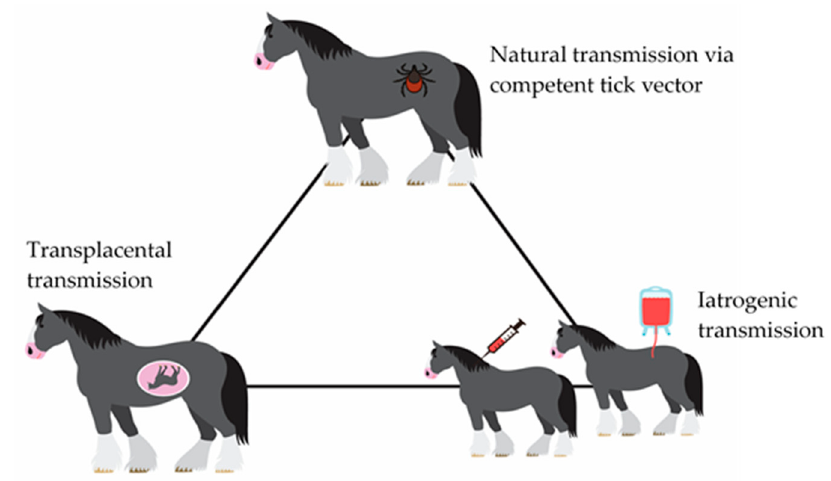
Figure 4. Possible transmission routes of equine piroplasmosis.